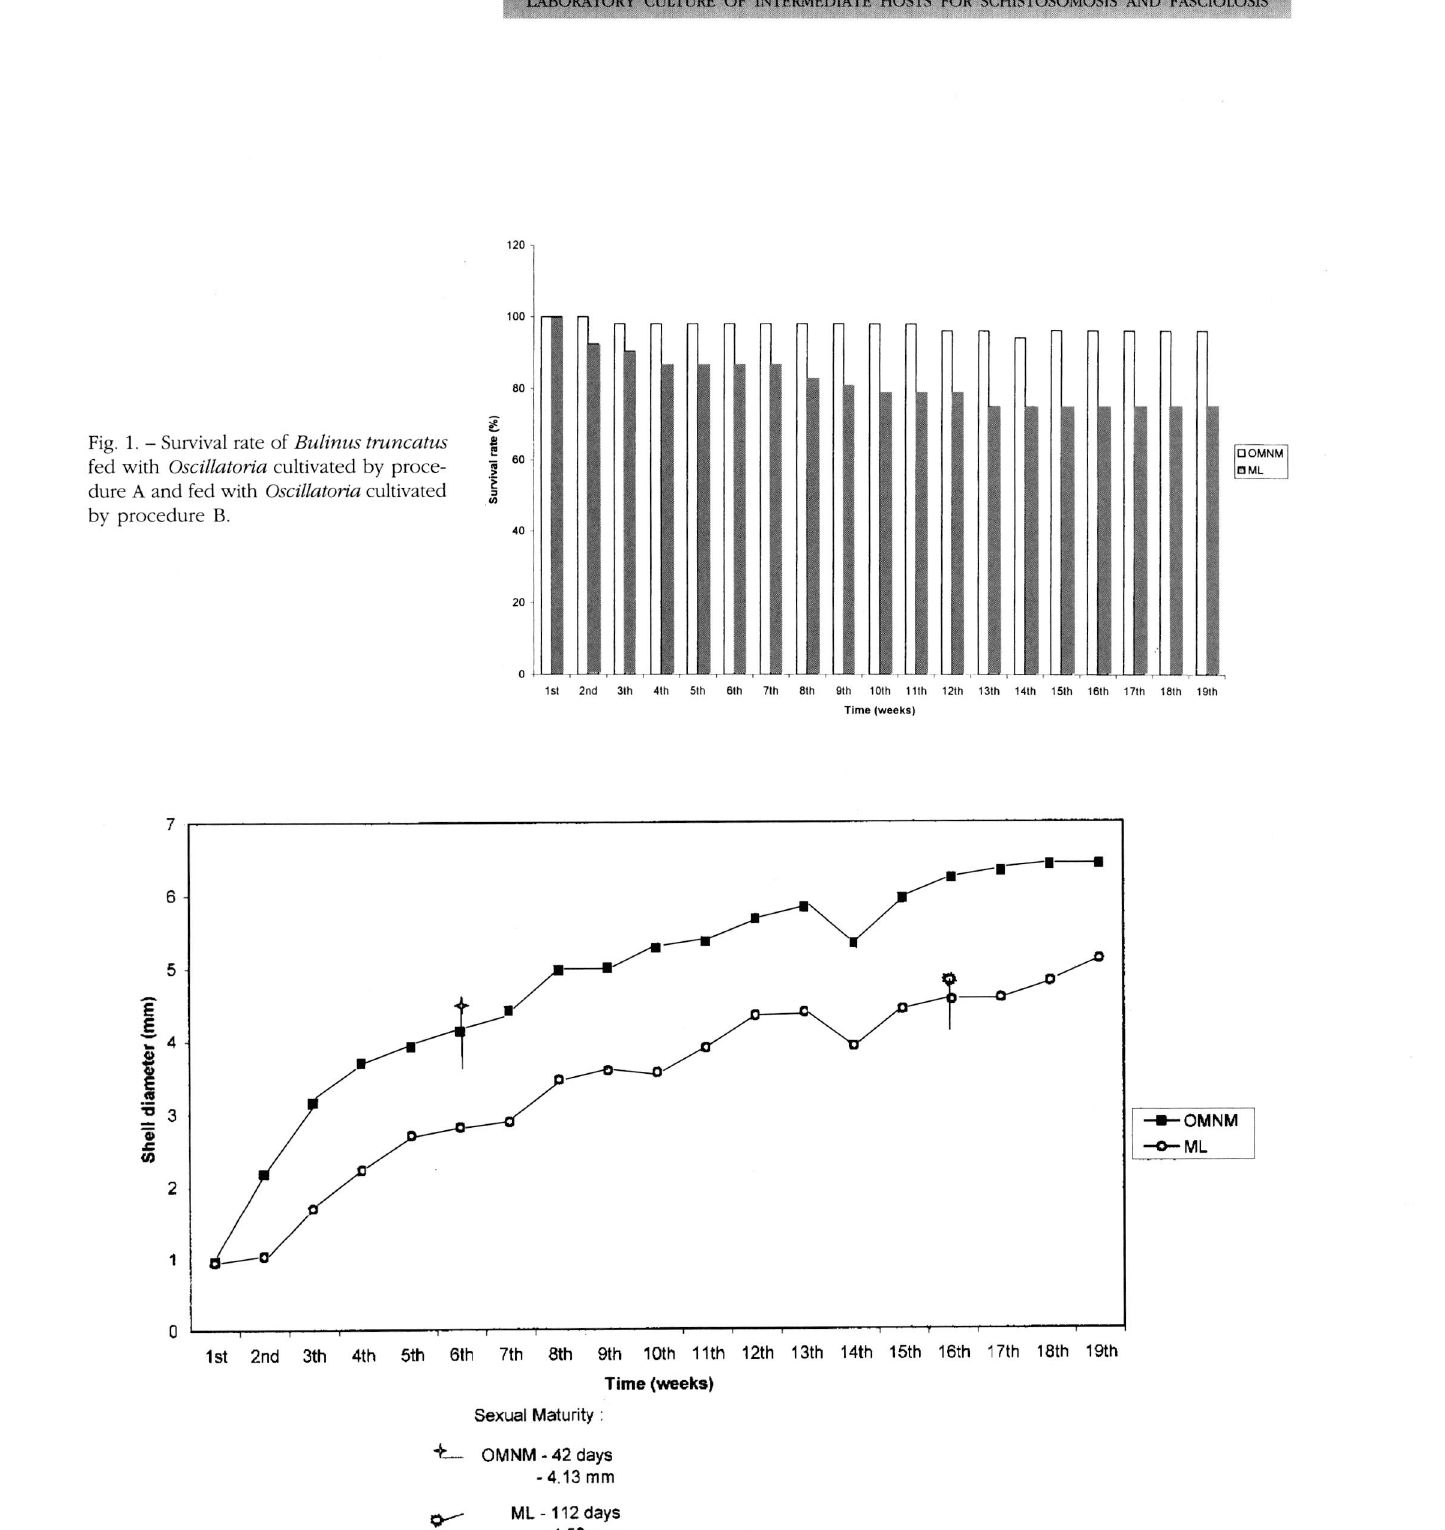
Fig. 2. - Growth results of Bulinus truncatus in the two tested media.